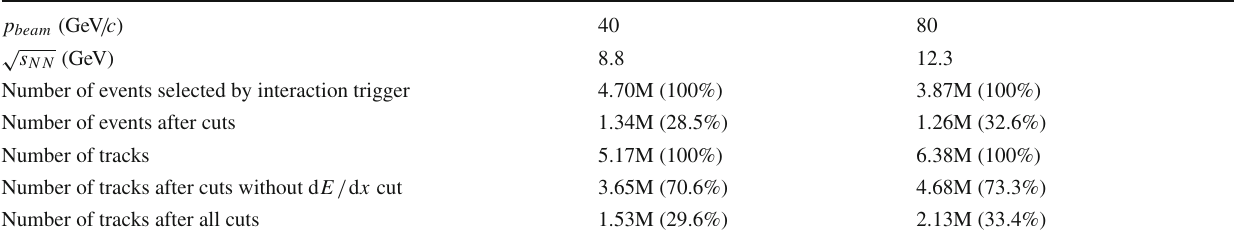
√ s NN is the energy available